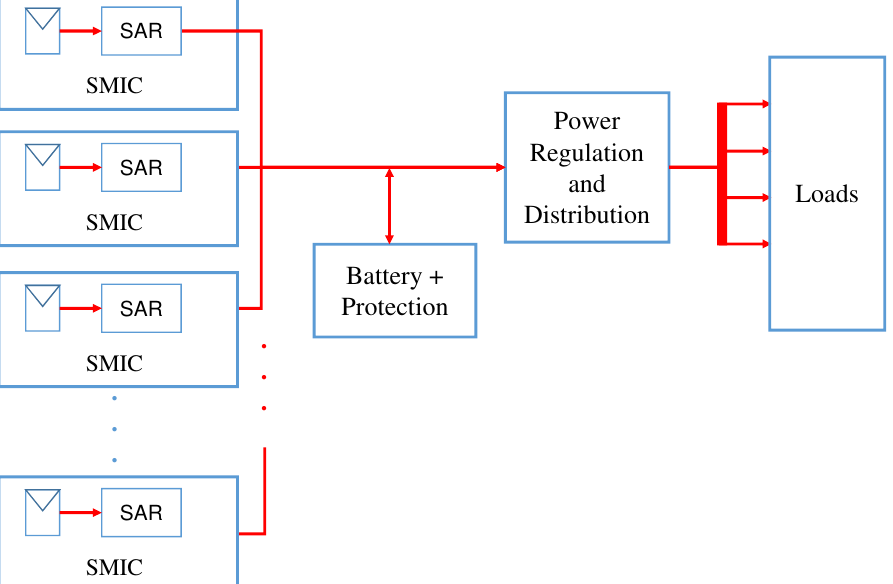
Figure 2. Architecture of EPS with multi-array of solar cells using Solar Module Integrated Converter (SMIC).